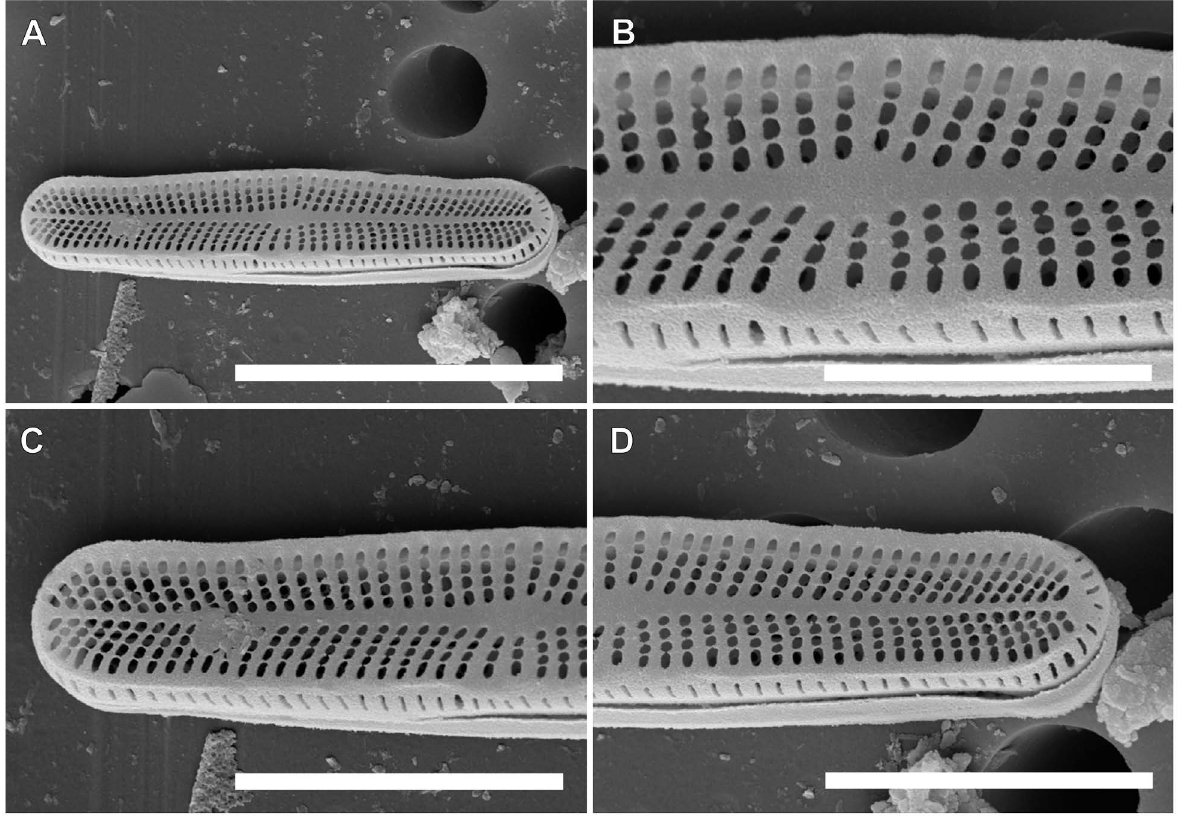
Figure 10. Achnanthidium anatolicum sp. nov., SEM micrographs. A . General external view of rapheless valve. B . Details of central area. C , D . Details of apices. Scale bars 10 µm (A), 4 µm (C, D), 2 µm